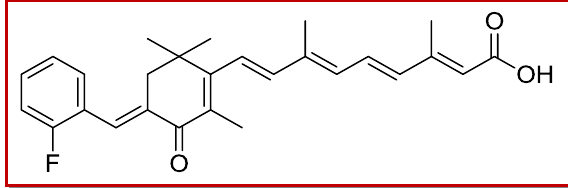
Figure 1: Structure of 2-florobenzaldehyde retinoic acid chal- cone